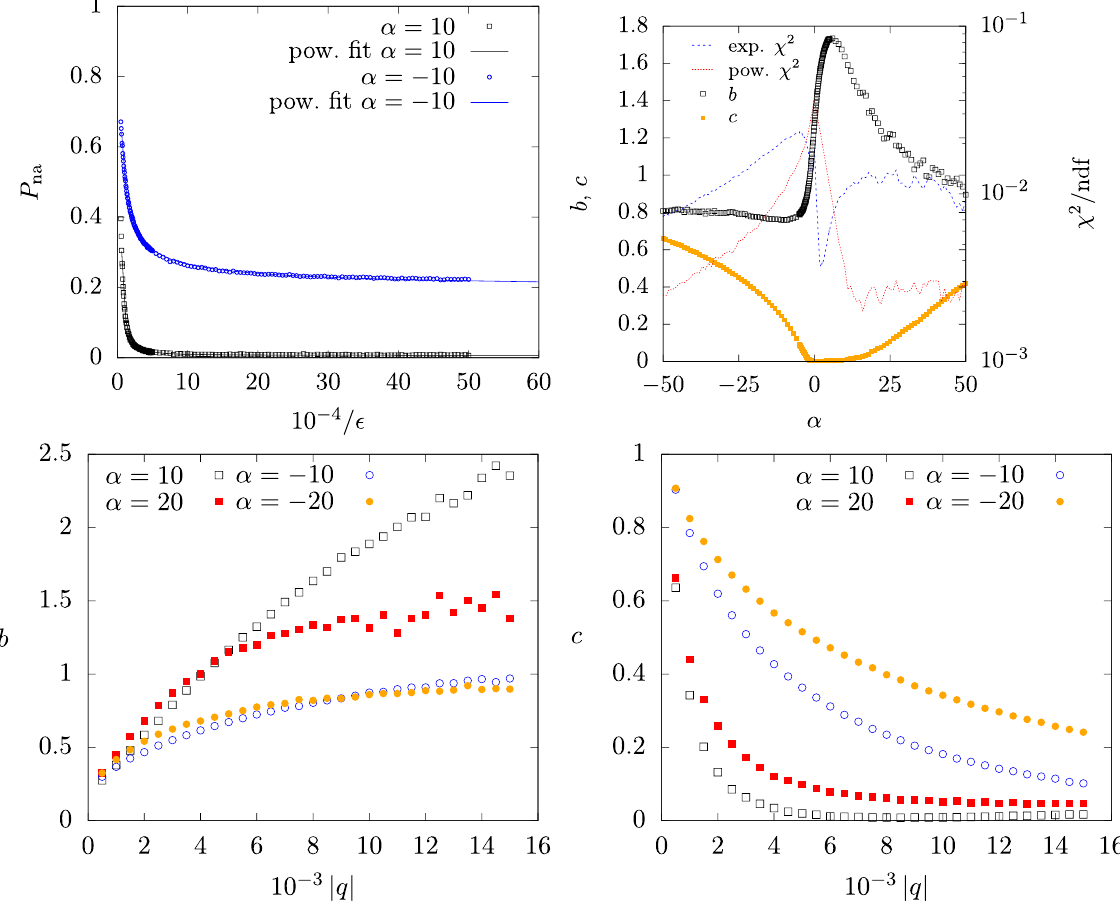
a ϵ b þ c , is fitted and the results na ¼ 10 − 4 , h I 4 × 10 − 4 x ; i i ¼ y ; i i ¼